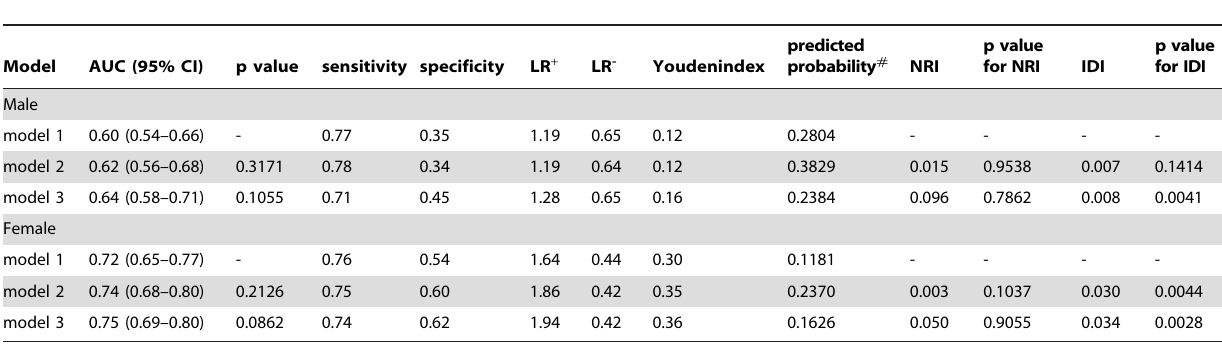
model 1: ADART, model 2: ADART + lifestyle behaviors at baseline, model 3: ADART + lifestyle behaviors + biomarkers; LR + =positive likelihood ratio test; LR - =negative likelihood ratio test; Youden index was defined as the maximum of (sensitivity + specificity-1); # : predicted probability for the optimal cutoff points; NRI: net reclassification improvement; IDI: integrated discrimination improvement.